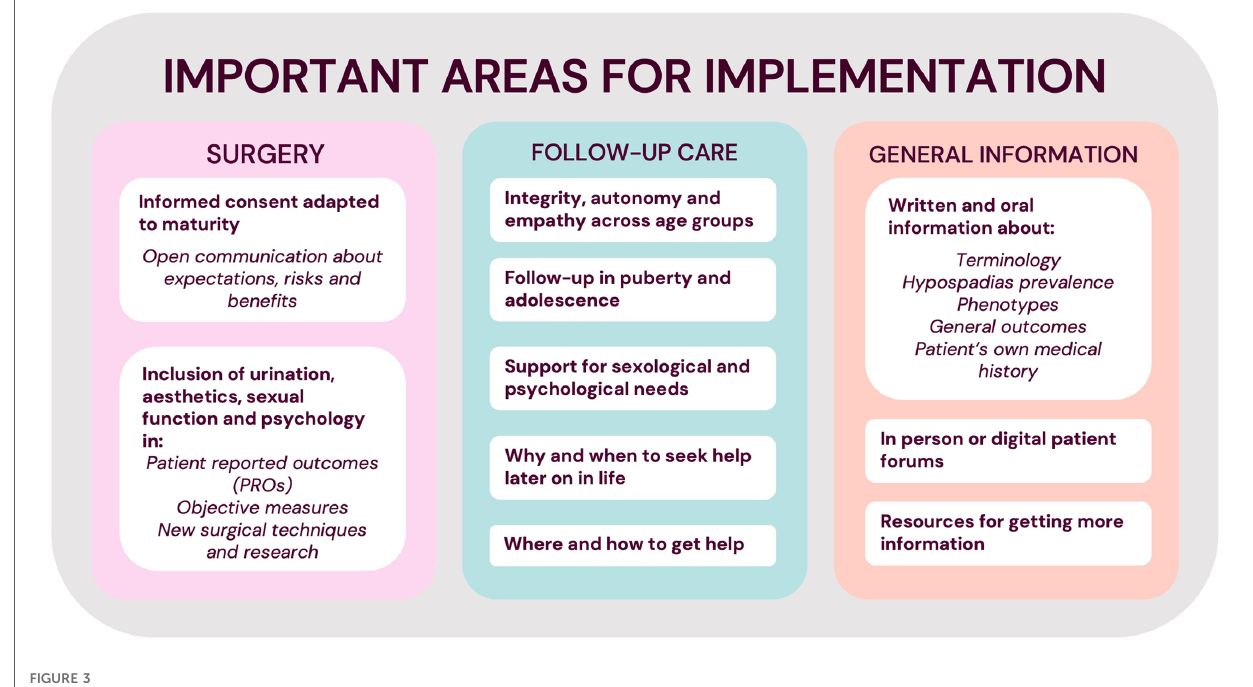
FIGURE 3 Summary of important factors to consider in hypospadias